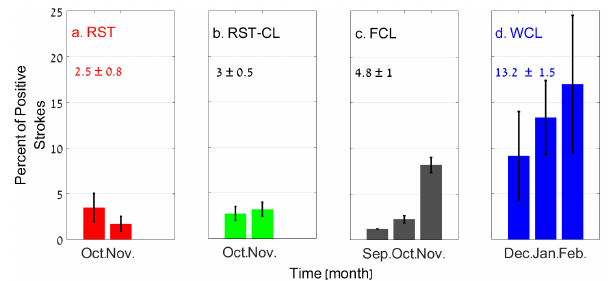
Figure 7. Interannual monthly mean fraction of positive strokes ac- cording to the four synoptic systems. The error bars indicate the perennial monthly standard error. Seasonal perennial monthly mean and standard error are shown for each